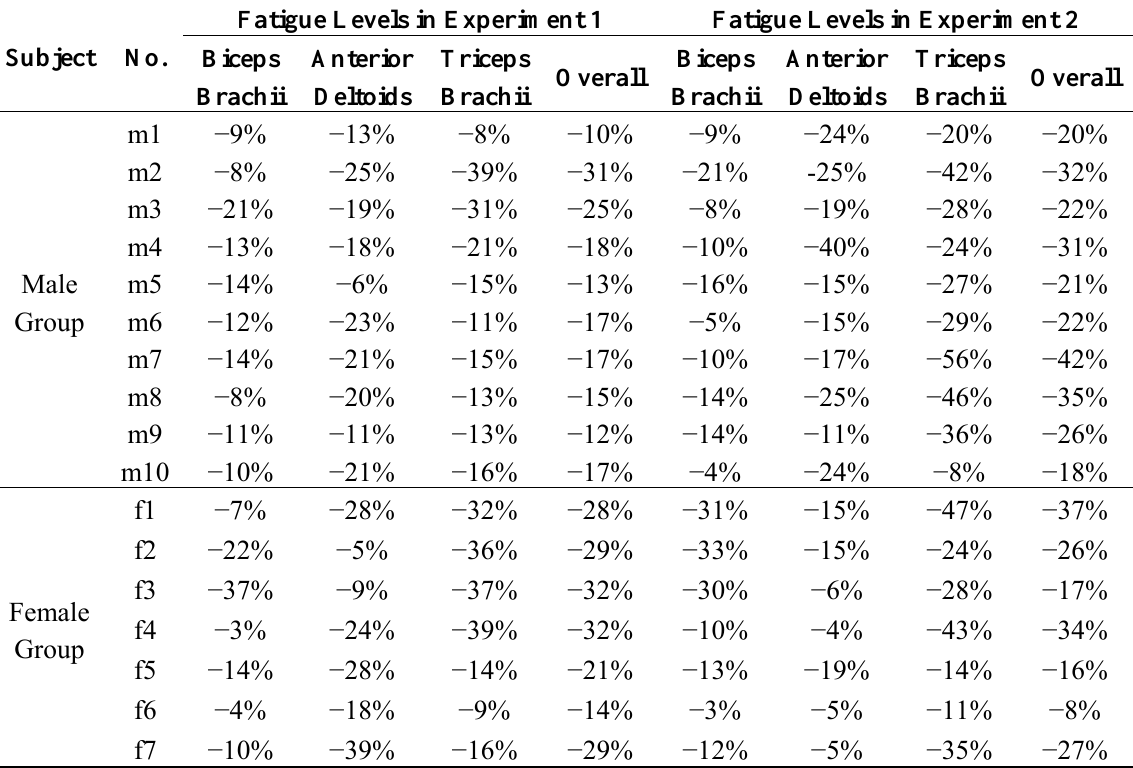
Table 2. Statistics of the fatigue